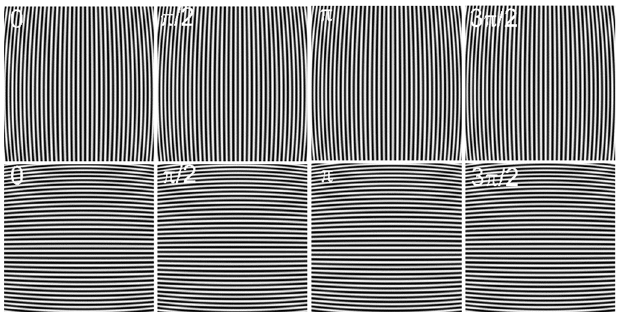
Figure 3. Simulated distorted fringe-patterns of size 512 512 × pixels by a single parameter divi- λ − − × and distortion center (273,289) . The longitu- sion model with a distortion parameter 6 = 1 10 dinal fringe-patterns with a phase shift of 0, /2, ,3 /2 π π π are at the first row and the transverse fringe-patterns with a phase shift of 0, /2, ,3 /2 π π π are at the second row.